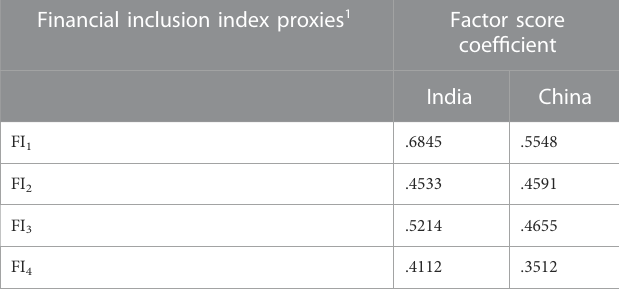
TABLE 3 Results of Components score coef fi cient matrix.